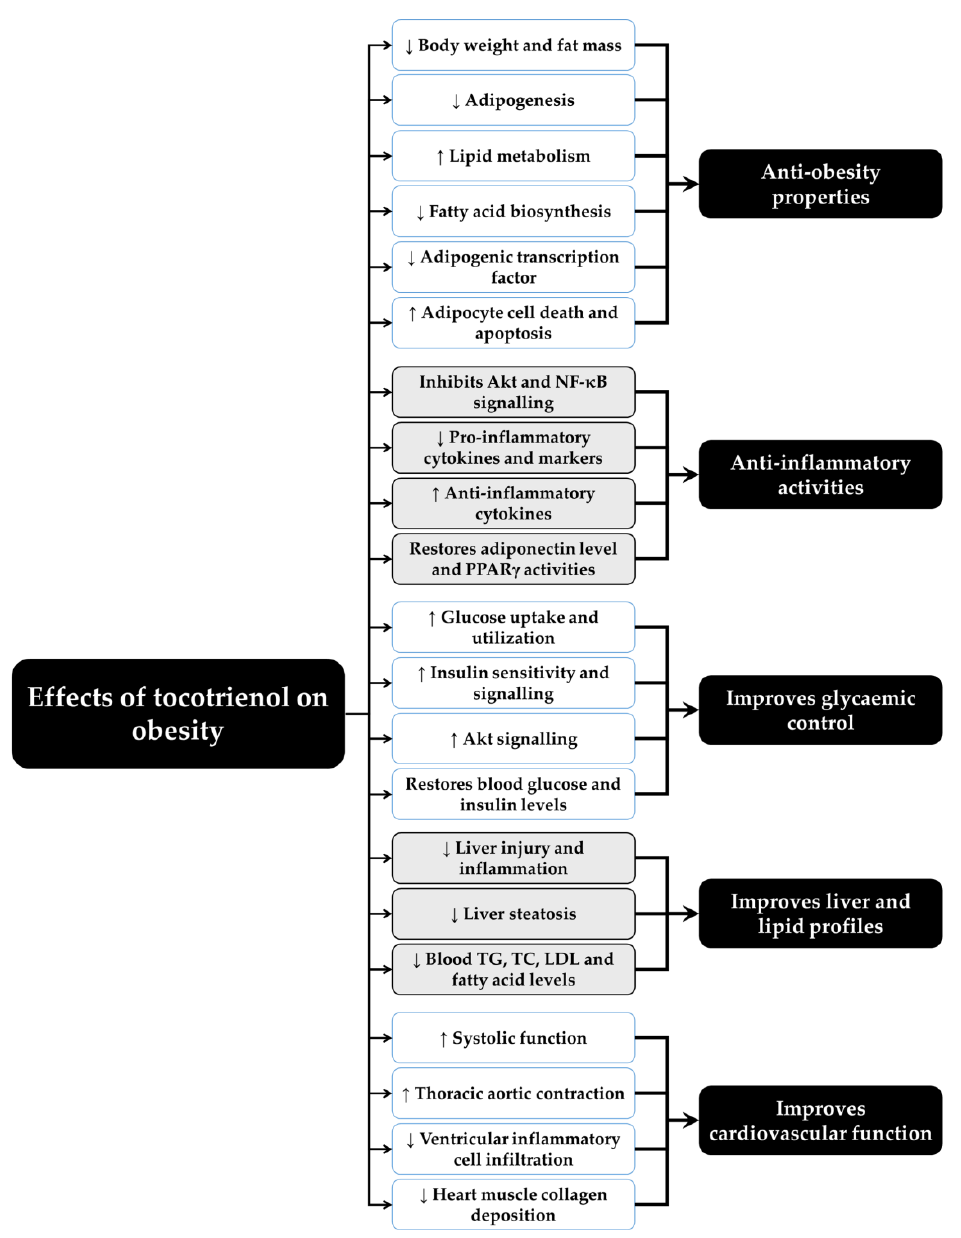
Figure 2. The beneficial effects of tocotrienol on obesity from cell culture, preclinical, and clinical studies. Abbreviations: ↑ = increase or upregulate, ↓ = decrease or downregulate, LDL = low-density lipoprotein, NF- κ B = nuclear factor- κ B, PPAR γ = peroxisome proliferator-activated receptor γ , TG = triglyceride, TC = total cholesterol.